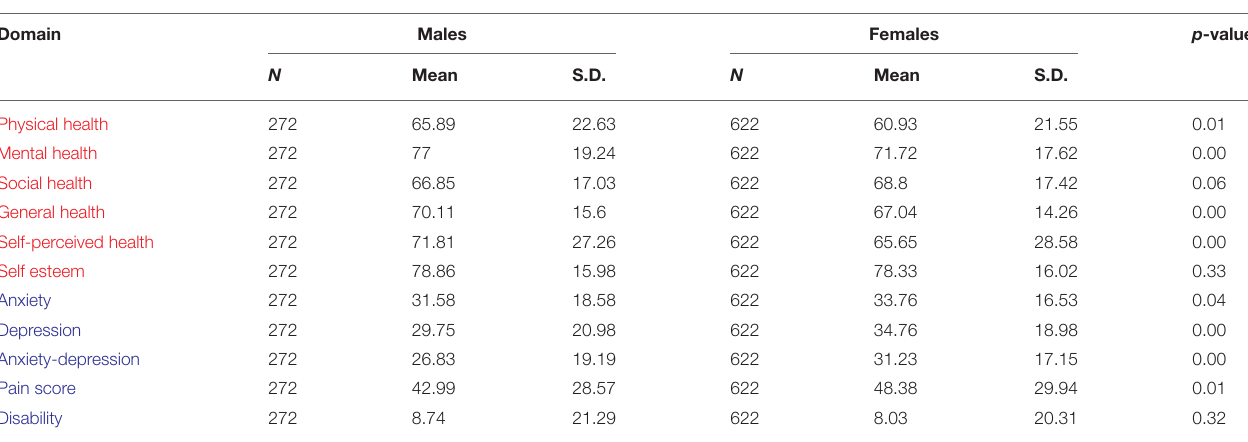
TABLE 2 | Duke health profile by total and sex-specific samples.